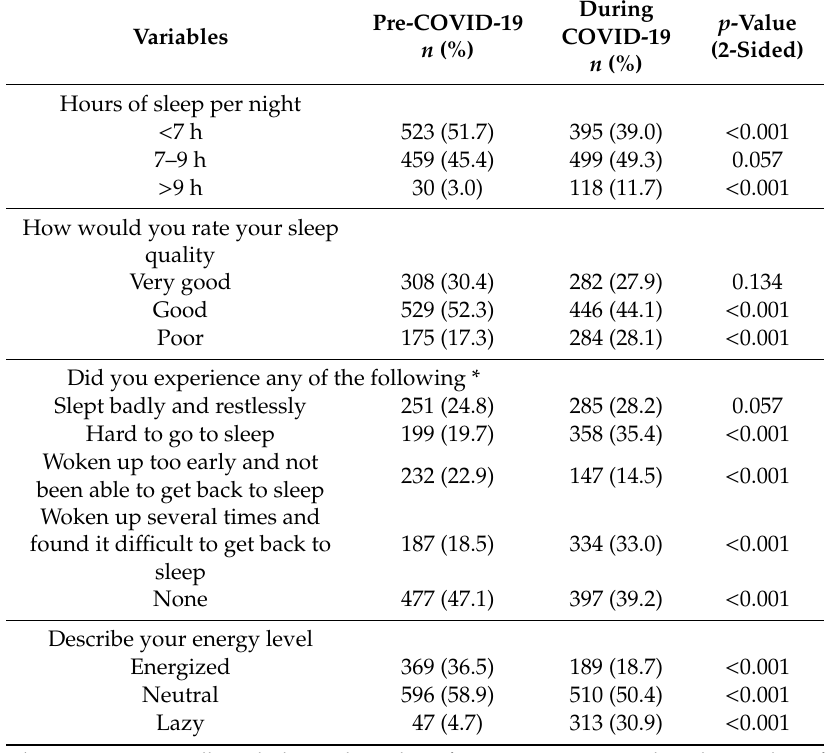
Table 8. Sleep pre- and during COVID-19 pandemic ( n = 1012).